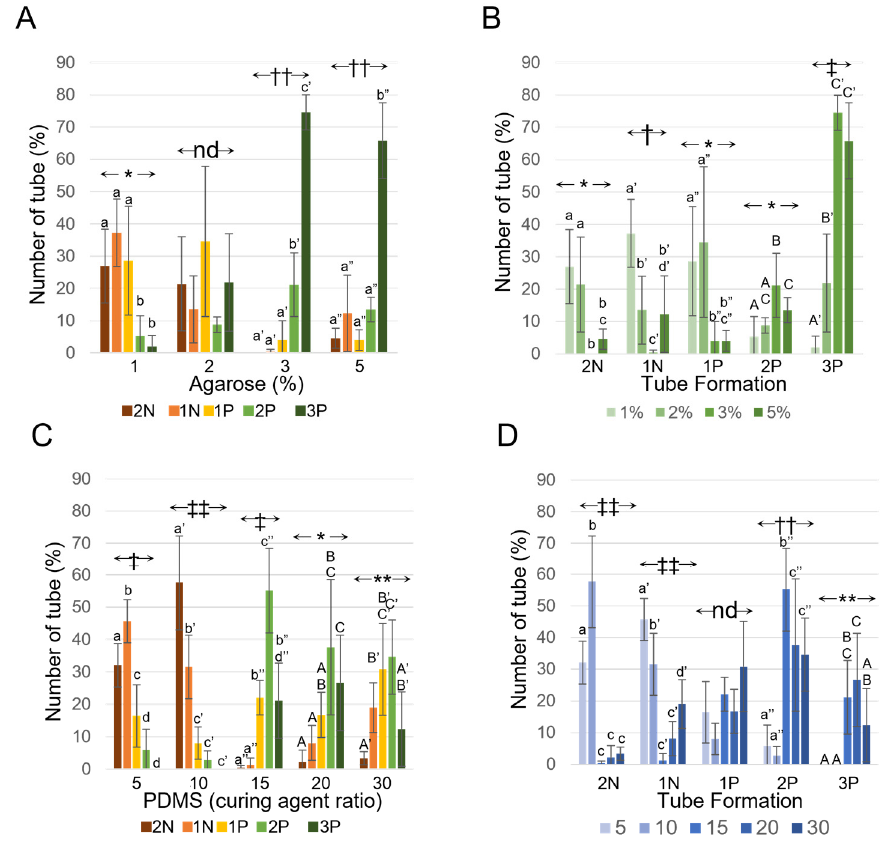
Figure 4. Percentage of tube formation on agarose ( A , B ) and PDMS ( C , D ) molds. Data are repre- sented in function of the ( A , C ) substrate composition and ( B , D ) the tube formation’s grade. Symbols indicate the p -value of the ANOVA test: p < 0.05 (*), p < 0.005 (**), p < 0.0005 (†), p < 0.00005 (††), p < 0.000005 (‡), p < 0.000001 (‡‡), and no differences (nd). A compact letter display is used to indicate non-significant differences from post hoc analysis (where a similar letter indicates no significant